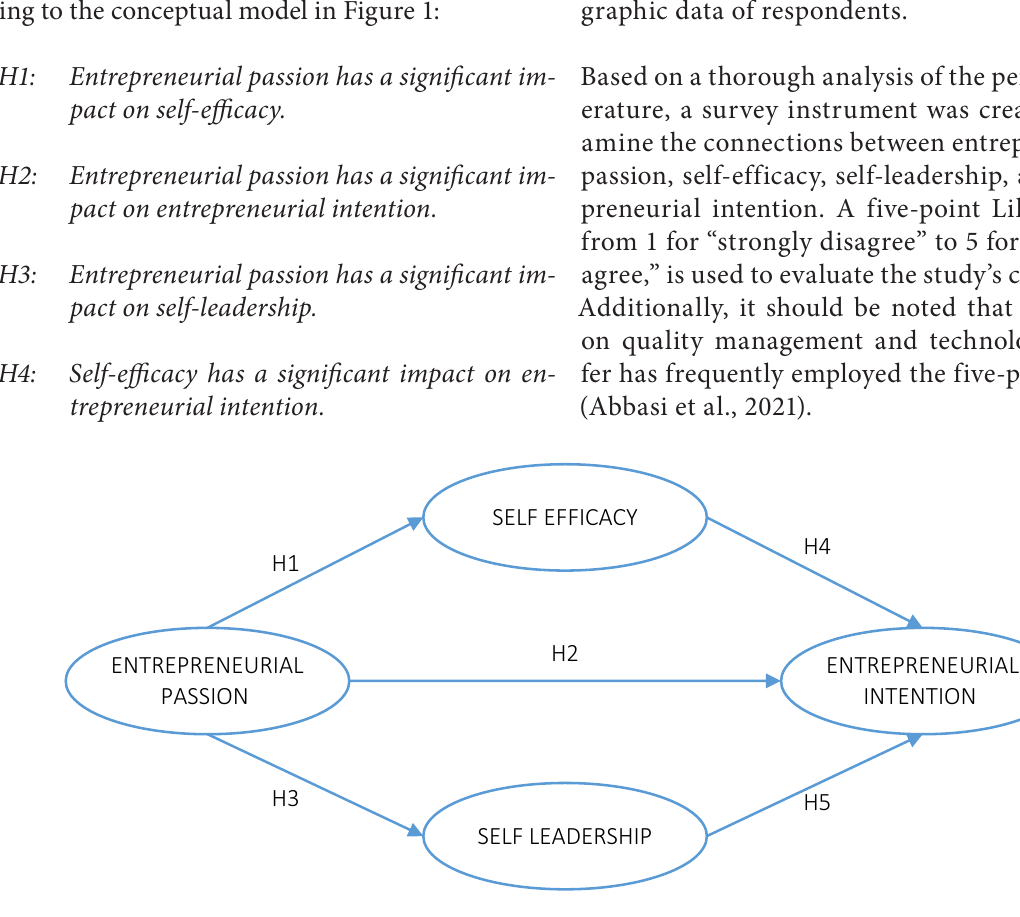
Figure 1. Hypothesized structural model